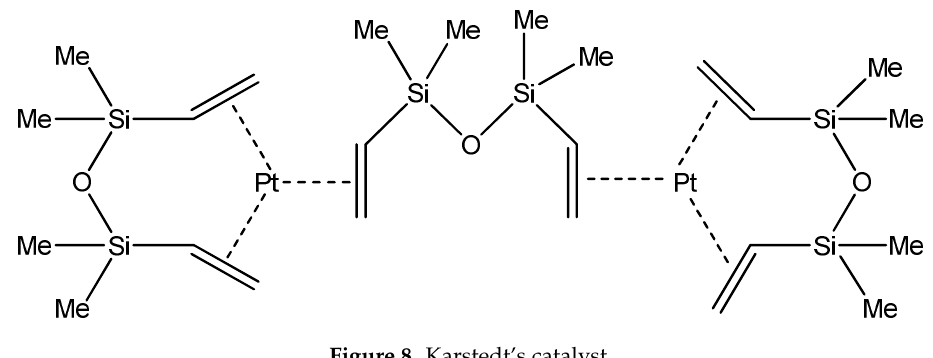
Figure 8. Karstedt’s catalyst.